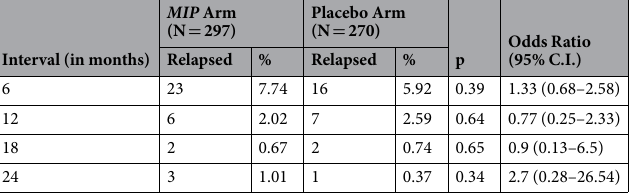
Table 3. Relapse rate (n = 567) ‡ . ‡ Total eligible for Relapse Analysis = 593( MIP Arm = 309; Placebo Arm = 284). Among the 593 patients, data on relapse is not available for 26 patients as they were enrolled beyond the project timelines making the numbers available for evaluation of relapse rate as